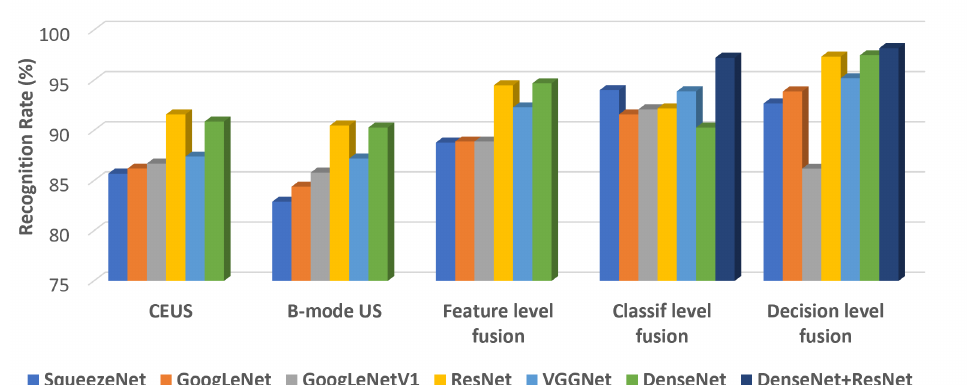
Figure 6. Comparison of the classification accuracy values achieved by the considered CNN architec- tures, for each fusion strategy.